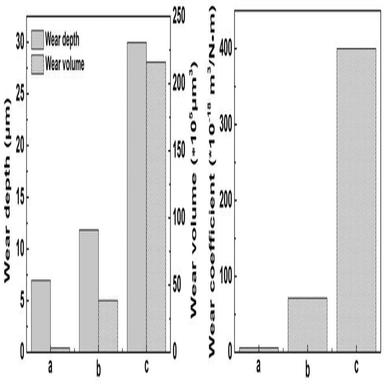
The maximum wear depth, the wear volume, and the wear coefficient of (a) Cr-coated cladding tested under 5 Hz; (b) Cr-coated cladding tested under 20 Hz; (c) uncoated cladding tested under 20 Hz.